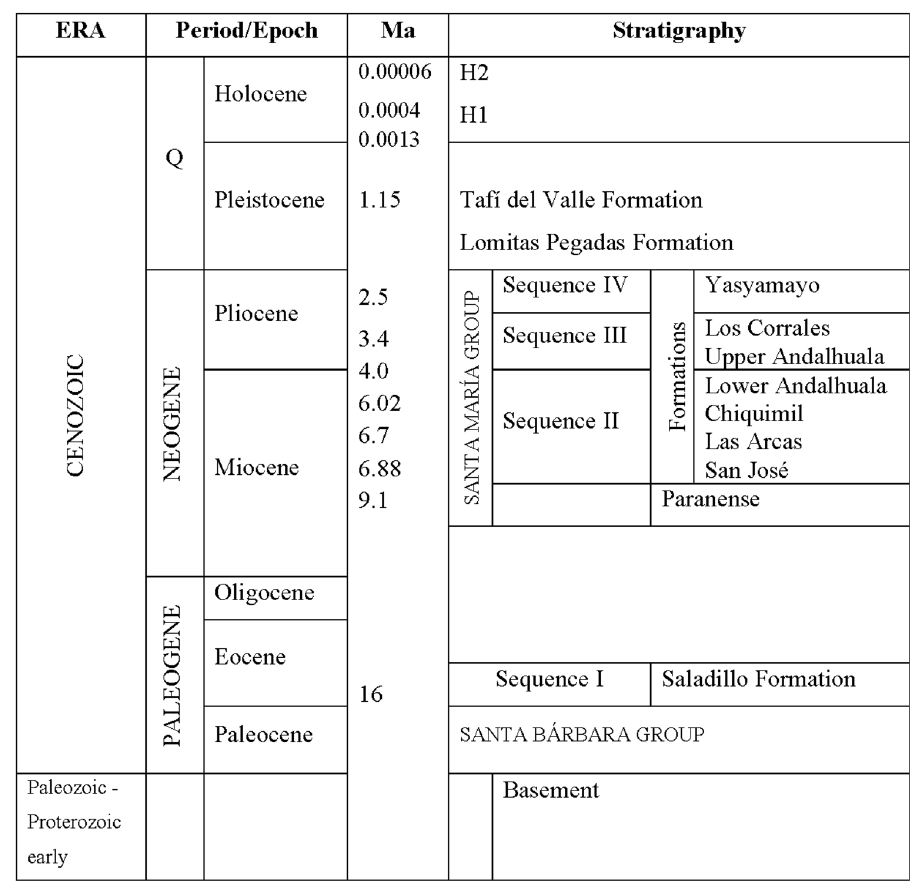
Table 1 Stratigraphic sequence of the Santa María Group according to Bossi et al. [15]. Dating made by Powell and González [24], Spagnuolo et al. [25], Georgieff and Díaz [26], Butler et al. [27], Marshall and Patterson [28], Strecker et al. [29]. Identification of quaternary morphosedimentary units by Peña Monné and Sampietro Vattuone [30] and Sampietro Vattuone et al. [31]. Q: